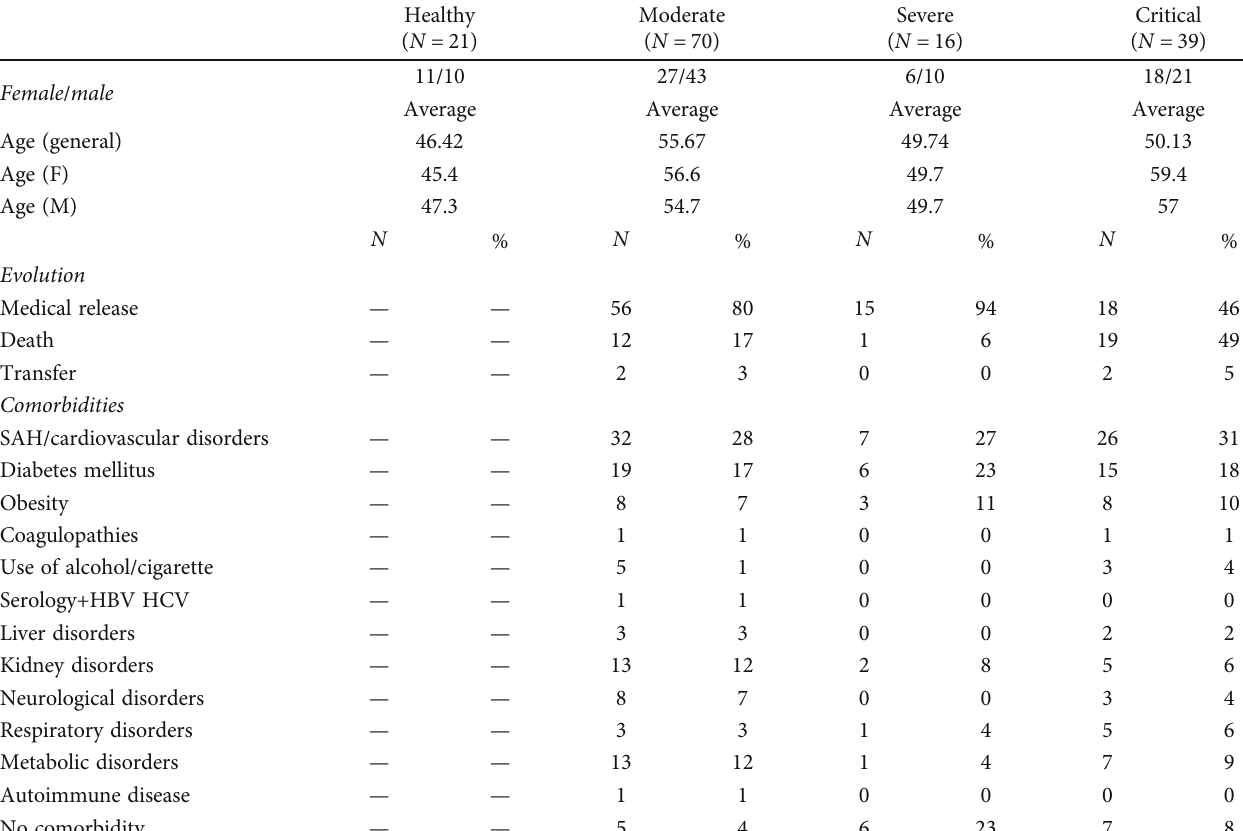
Table 1: Demographic data of the COVID-19 patient cohort and control subjects used in the